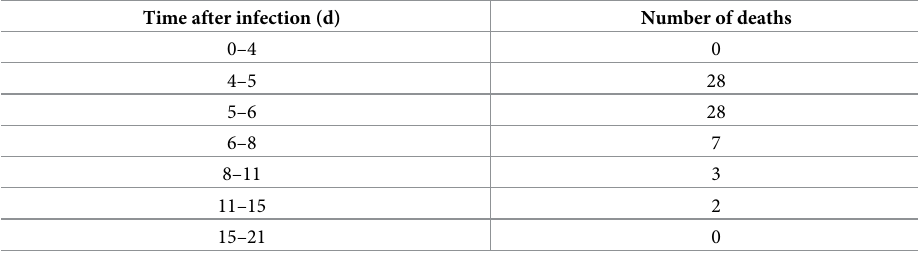
Table 1. The death of mice infected with Japanese encephalitis virus